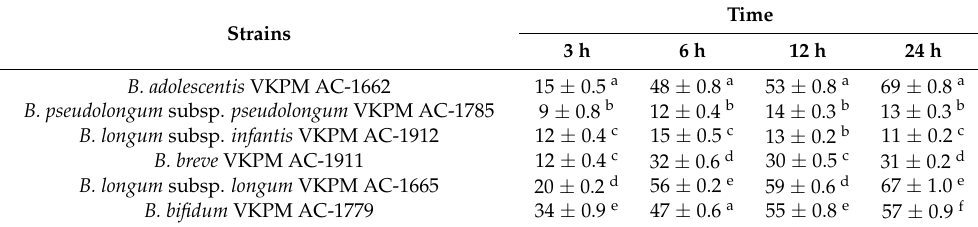
Table 10. Autoaggregation percentage of Bifidobacterium strains.